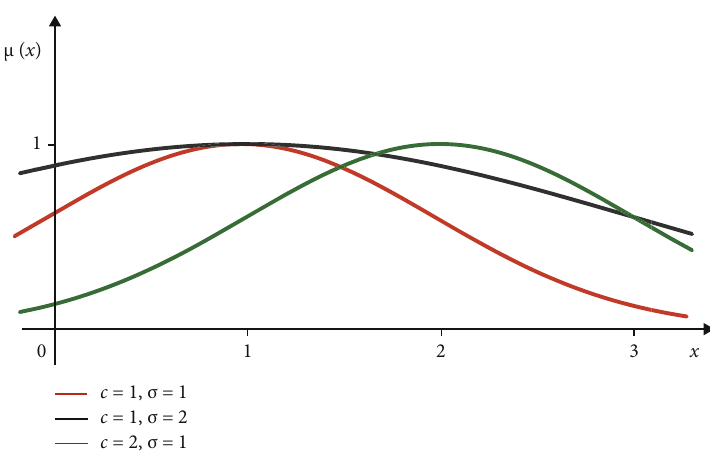
Figure 4: Fuzzy sets with di ff erent Gaussian membership functions MF